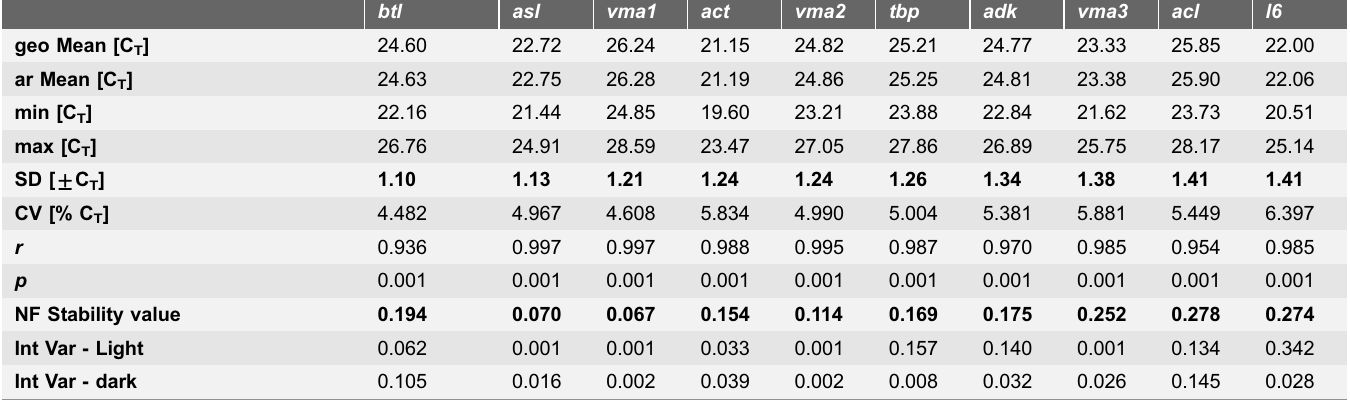
Table 2. Descriptive statistics and stability values of candidate reference genes under conditions of light/dark cycling (n 5